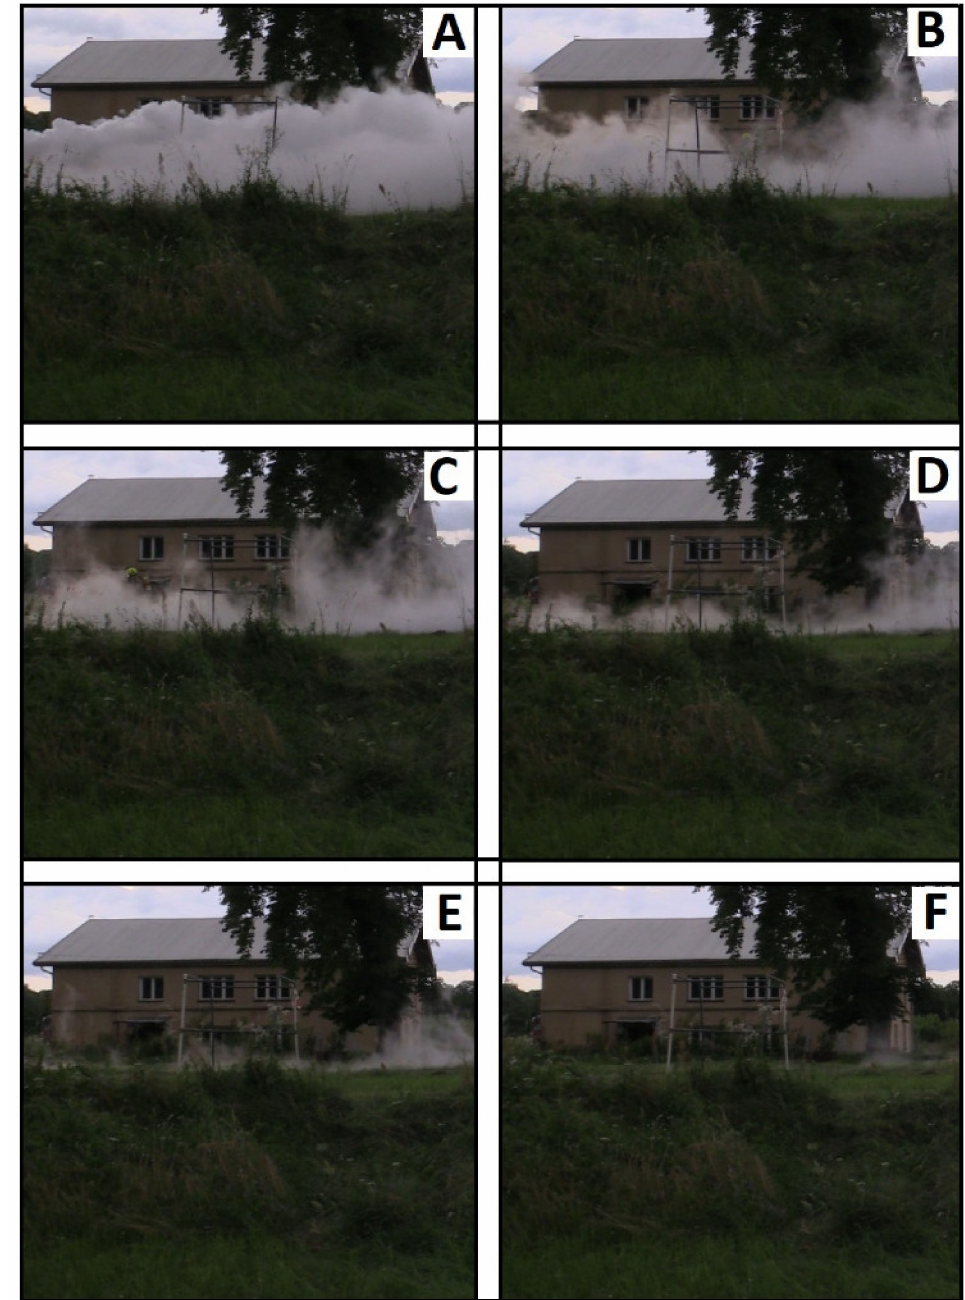
Figure 10. Shape of the gas cloud at a distance of x ≤ 7 m. ( A ) Supply stop; ( B ) 3 s after supply stop; ( C ) after 6 s; ( D ) after 9 s; ( E ) after 12 s; ( F ) after 15 s. Atmospheric conditions of the measurement series: T = 20.3 ◦ C, v = 0.67 m/s, RH = 44%, p = 1002.7 hPa. Release parameters: Q = 1.7 kg/s, p out = 5.9 atm, t = 163 s, h = 0.75